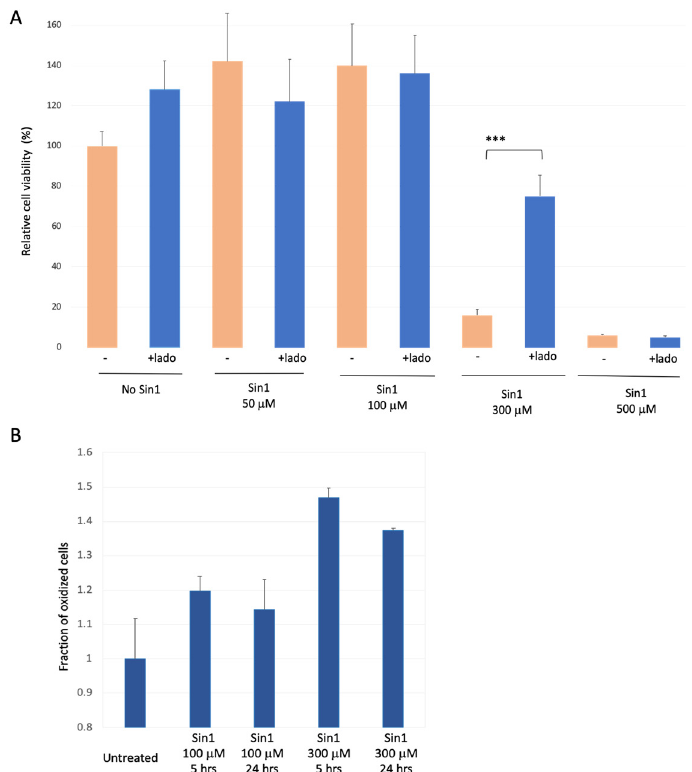
Figure 2. SH-SY5Y cells under chronic long-term oxidation stress and ladostigil treatment. ( A ) Cell viability upon increasing Sin1 concentration in the presence or absence of ladostigil (lado, 5.4 µM) was monitored . Cell survival difference that is statistically significant is marked (***, p -value < 0.005). ( B ) Cells were exposed to Sin1 (100–300 µM) for 5 and 24 h, and the redox state of transfected cells expressing GFP was monitored (see Materials and Methods). The fraction of the oxidized cells is determined relative to untreated cells. Experiments included internal controls of a fully oxidized and fully reduced condition (Supplementary Figure S1).